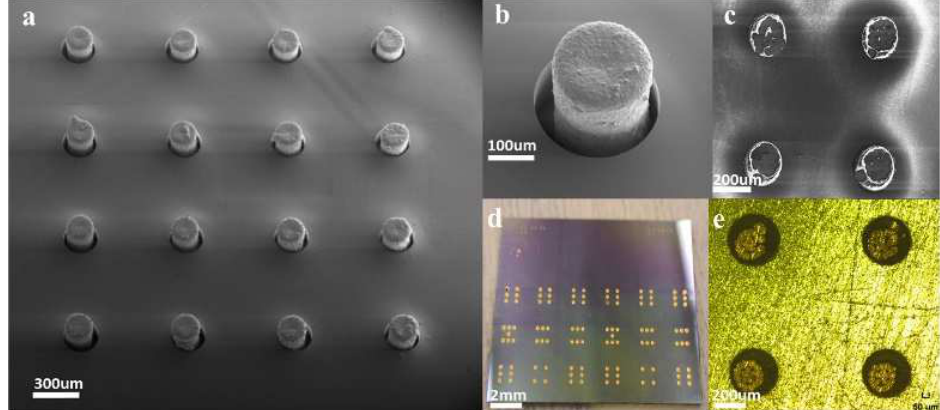
Figure 10. Images of Cu-CNT composite TSVs. ( a ) Cu-CNT composite structures inside the silicon vias; ( b ) the image of a Cu-CNT composite in the via; ( c ) the surface topography of Cu-CNT composite TSVs after polishing; ( d ) a test sample with Cu-CNT TSVs; ( e ) the image showed top surface topography of Cu-CNT composite TSVs after polishing. Reprinted with permission from ref. [28].